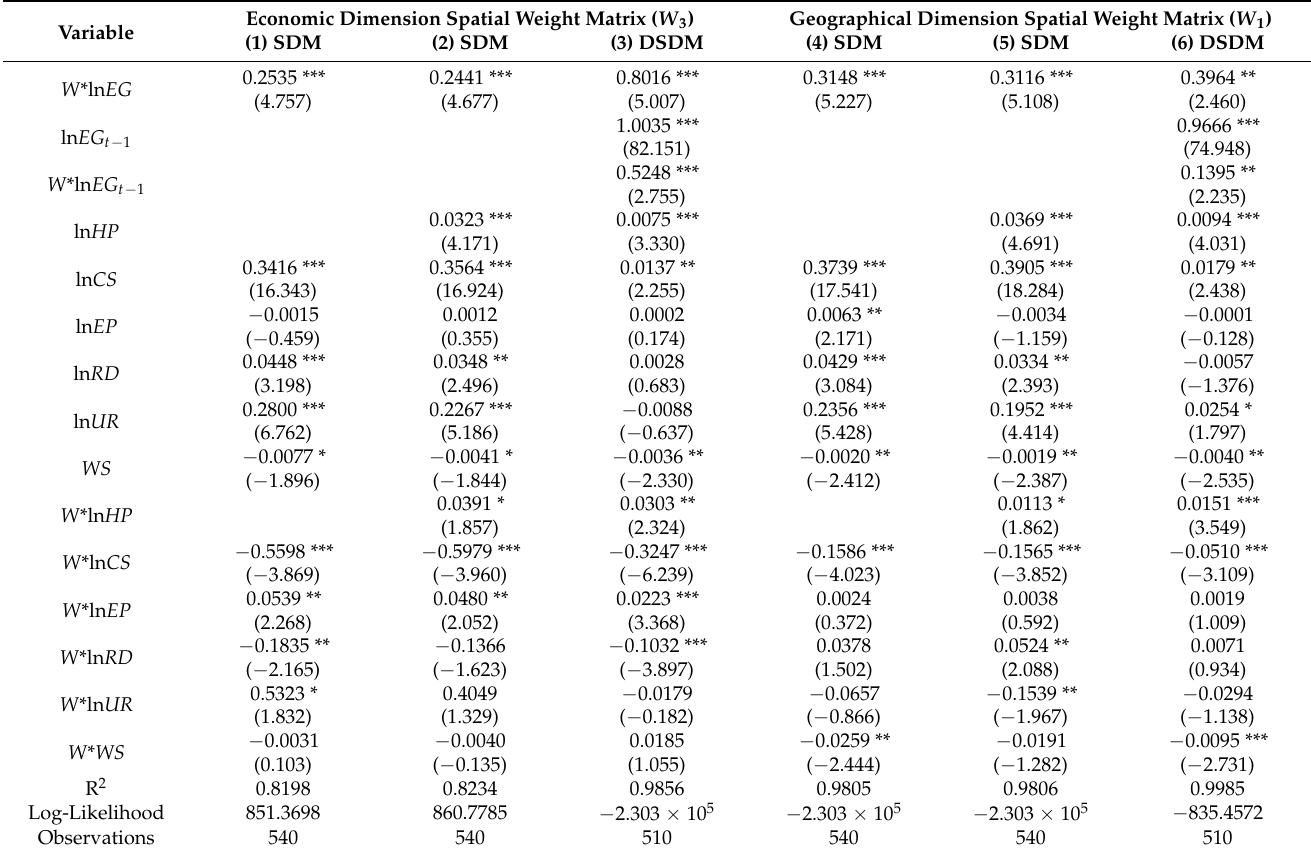
Table 4. Empirical results of the impact of hydropower on regional economic